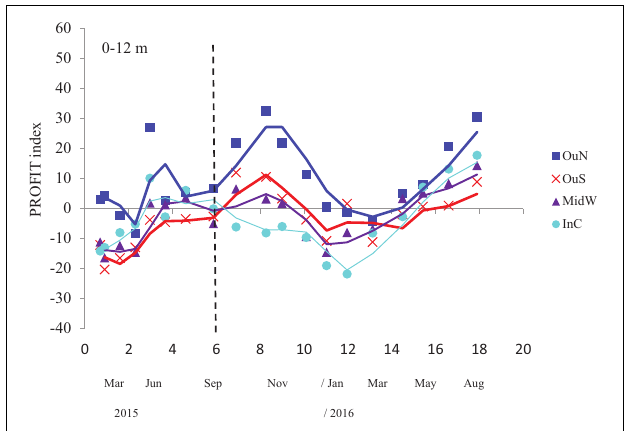
FIGURE 7 | PROFIT index variability throughout the whole cultivation cycle (moving average) of the mussels at the four experimental locations of the Ría de Arousa. Values shown correspond to the entire length of the rope (0–12 m) because of the non-significant differences by water depth. The dashed line represents the timing of the thinning out process usually carried out between seeding and harvest. Since each component of the PROFIT (expressed as a percentage) was corrected to the mean value for the four experimental sites and the whole cultivation period, positive and higher values represent better performance of the mussels.